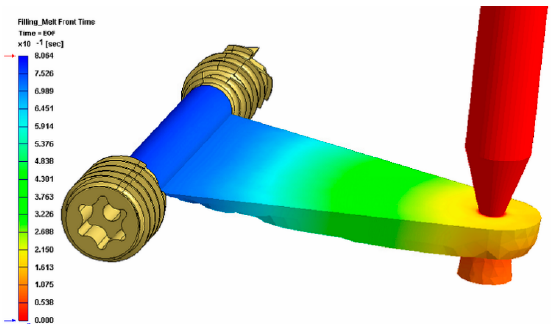
Figure 9. Simulation result of the overmolding cycle.